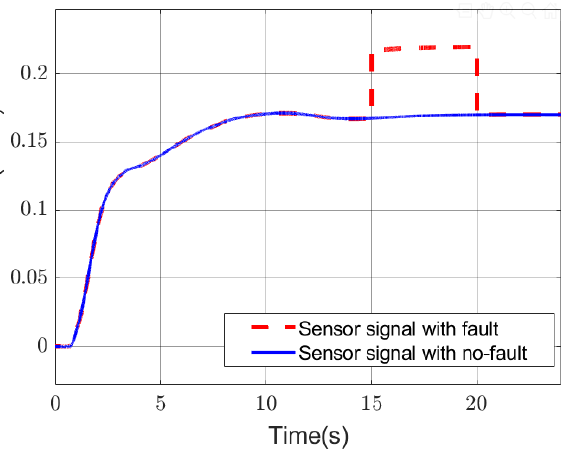
Figure 10. Yaw rate sensor signal (Blue line: sensor signal with no fault; red dotted line: sensor signal with a positive offset fault).